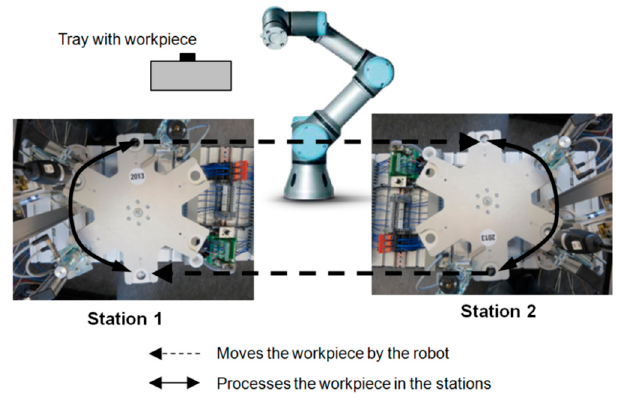
Figure 16. Technological structure of application example 2.